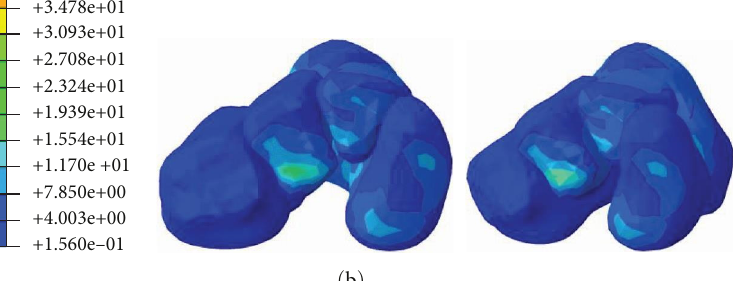
F IGURE 8: Stress distribution of mid-foot bone (a) at t 1 , t 2 , and t 3 gait instants in RFS jogging (from left to right) and (b) at t 2 and t 3 gait instants in FFS jogging (from left to